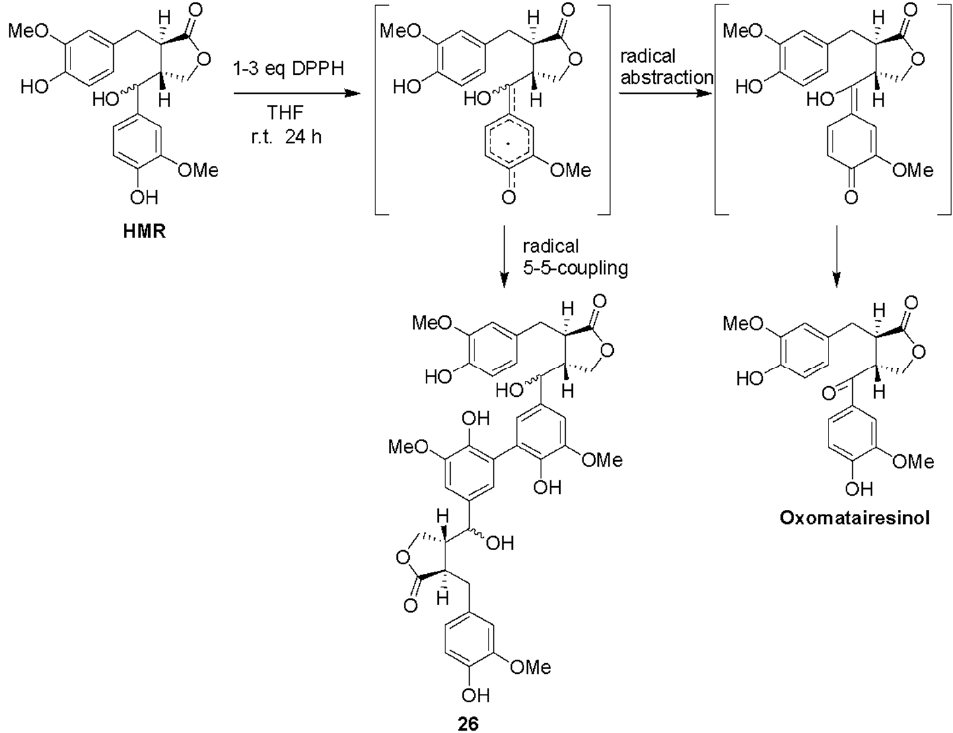
Scheme 13. Reaction products of HMR with the free radical DPPH.